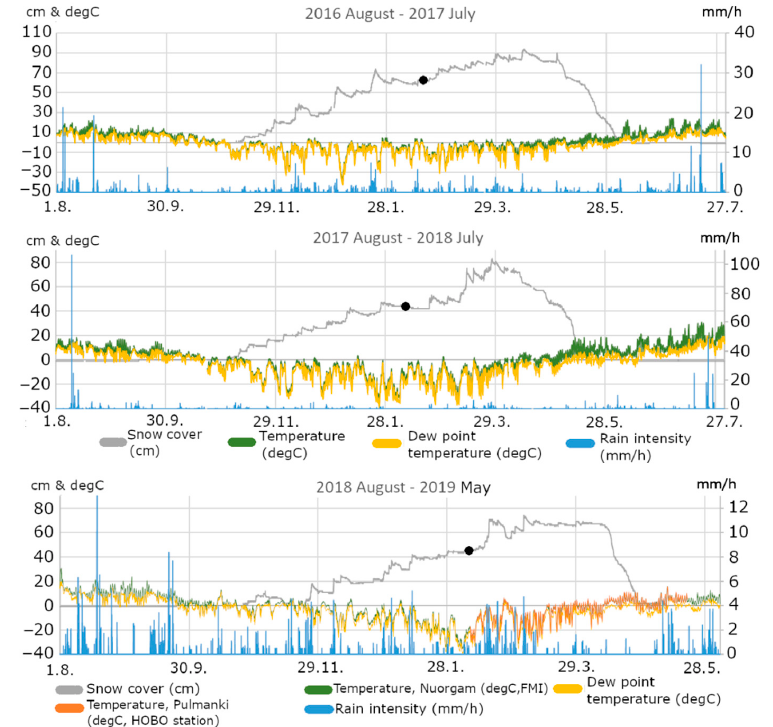
Figure 3. The air temperature, rain intensity and snow depth measured at the FMI’s Nuorgam weather station 2016–2019. Also shown is the winter-spring 2019, which was measured at the Pulmanki River (HOBO station), 400 m upstream from the ice-thickness measurement locations. The black dots depict the day of snow and ice thickness measurements at the Pulmanki River.